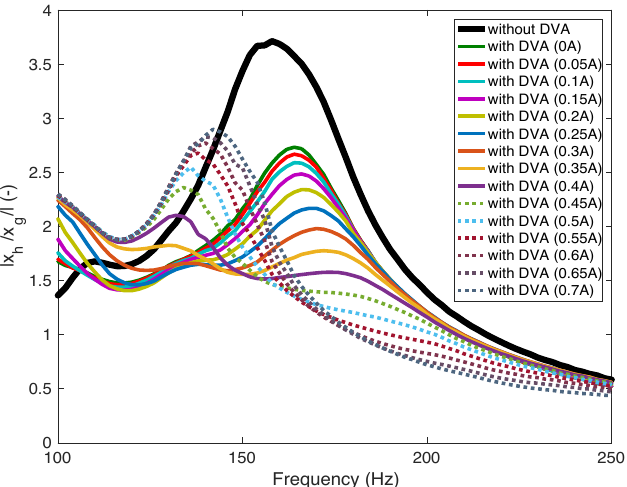
Figure 10. Vibration isolation performance of the MRE-DVA (3 mm pad thickness). Figure 9: Effect of the MRE pad thickness on vibration isolation performance of the MRE- based DVA.